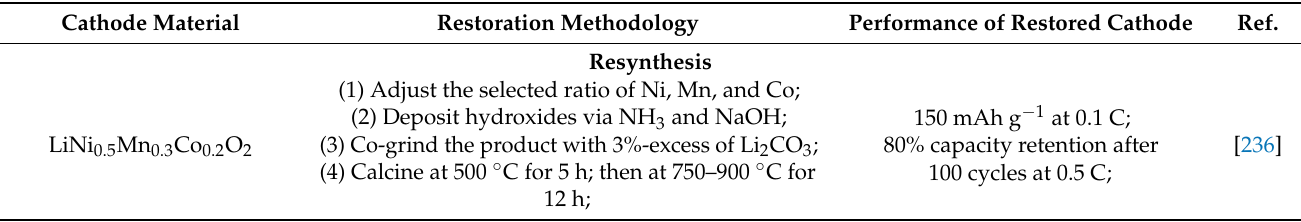
Table 3. Summary of LIB cathode material direct restoration